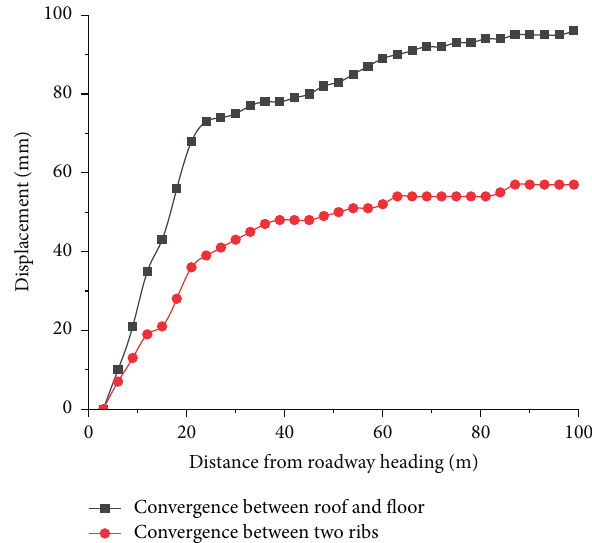
Figure 14: Convergence displacement of roadway surrounding rock surface in the No. 3 roadway.